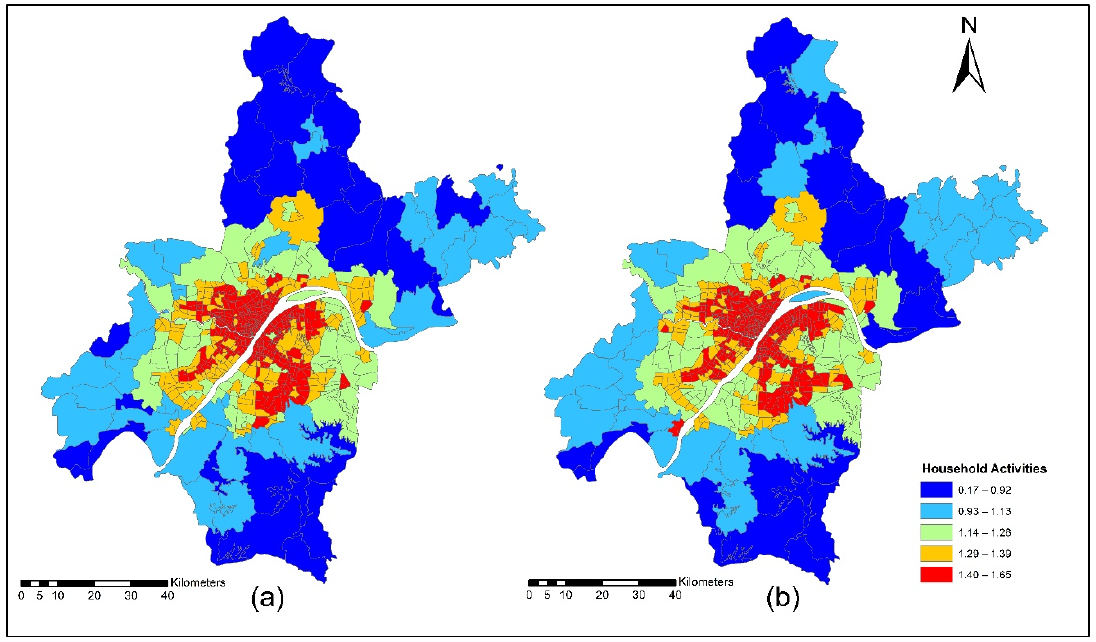
Figure 10. ( a , b ) Accessibility of household activities: ( a ) during off-peak for the year 2012; ( b ) during off-peak for the year 2015.